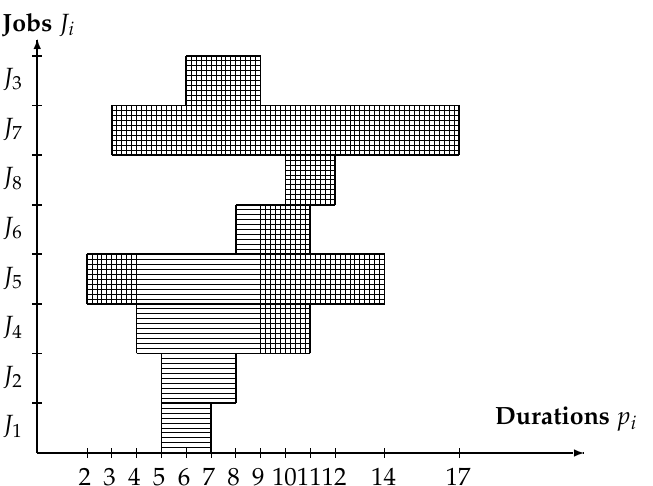
Figure 2. The segments of non-optimality (double-shaded) and the segments of conditional optimality (shaded) for the jobs J i ∈ J in the permutation π 2 = ( J 1 , J 2 , J 4 , J 5 , J 6 , J 8 , J 7 , J 3 ) ∈ S